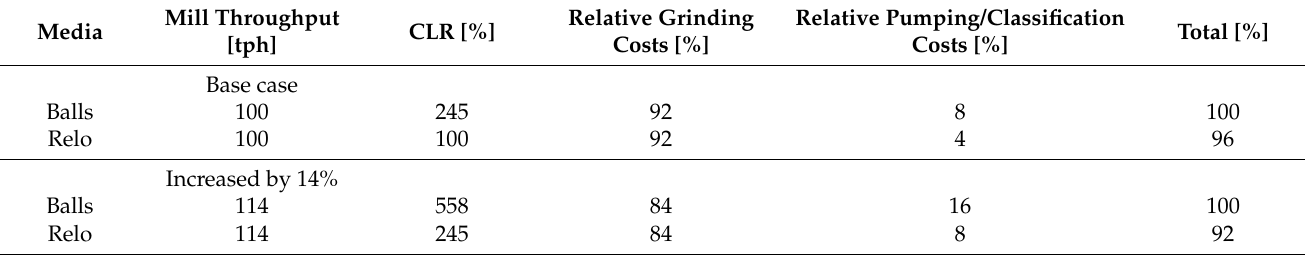
Table 8. Trade-off between ball charge and RGM charge in terms of circulating